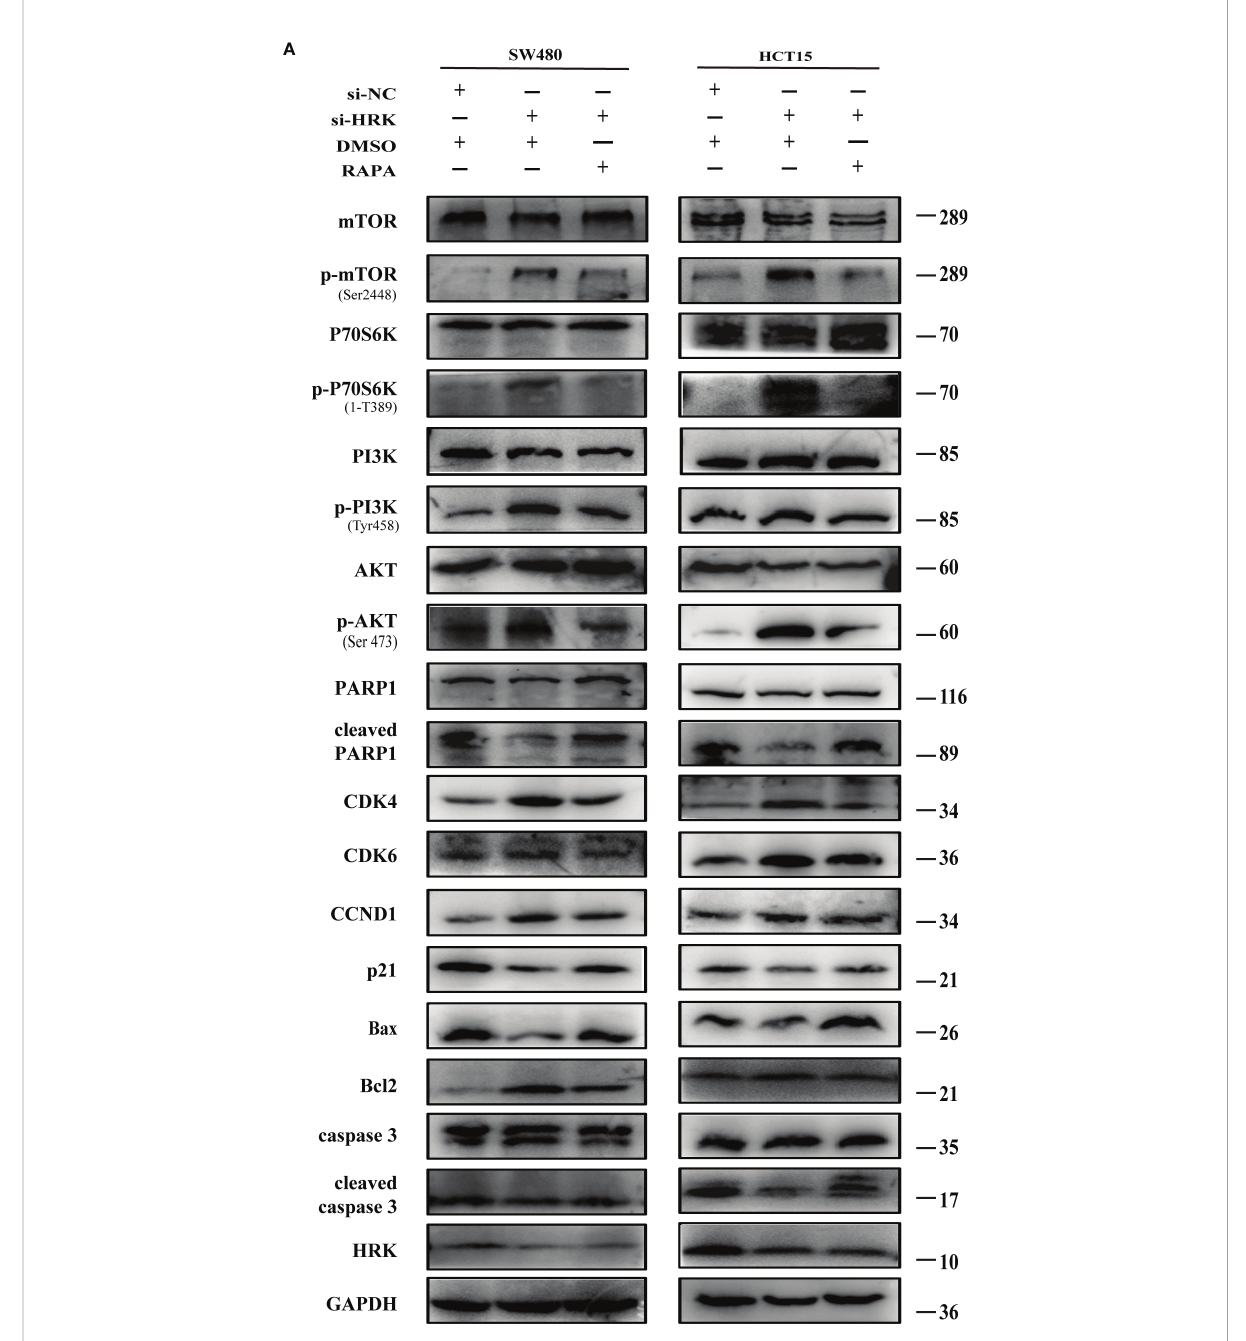
FIGURE 8 Effect of rapamycin on PI3K/AKT/mTOR signaling pathway in cell lines with reduced HRK expression (A) , Western blotting was performed to detect mTOR, p-mTOR, PI3K, p-PI3K, P70S6K, p-P70S6K, AKT, p-AKT, PARP1, cleaved PARP1, CDK4, CDK6, CCND1, P21, Bax, Bcl-2, caspase3 and cleaved caspase3 in CRC cells after HRK knockdown or RAPA (100 nM) treatment for 24 h. + represents the use of the material. - means that the material is not